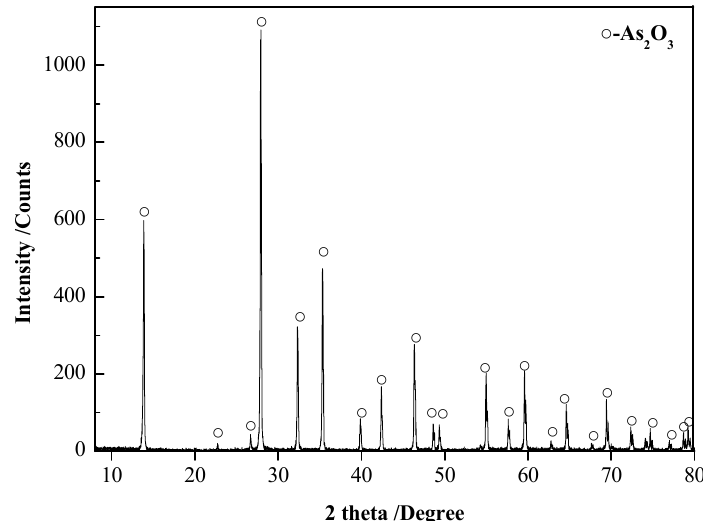
Figure 18. XRD patterns of the dust.